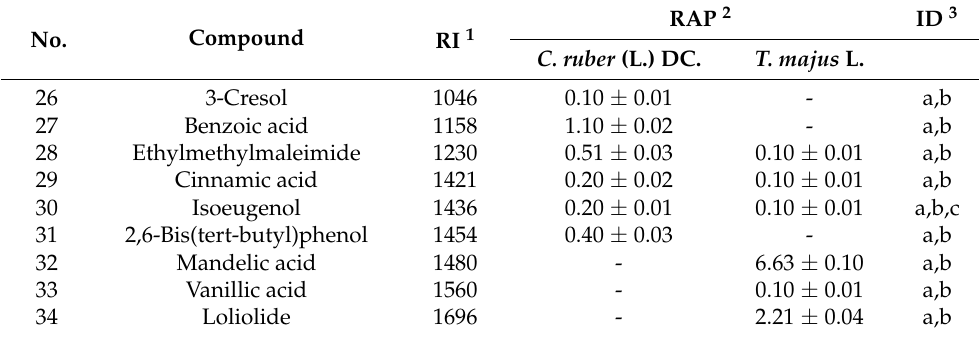
Table 2. Chemical constituents identified in the dichloromethane fractions of Centranthus ruber (L.) DC. and Tropaeolum majus L.